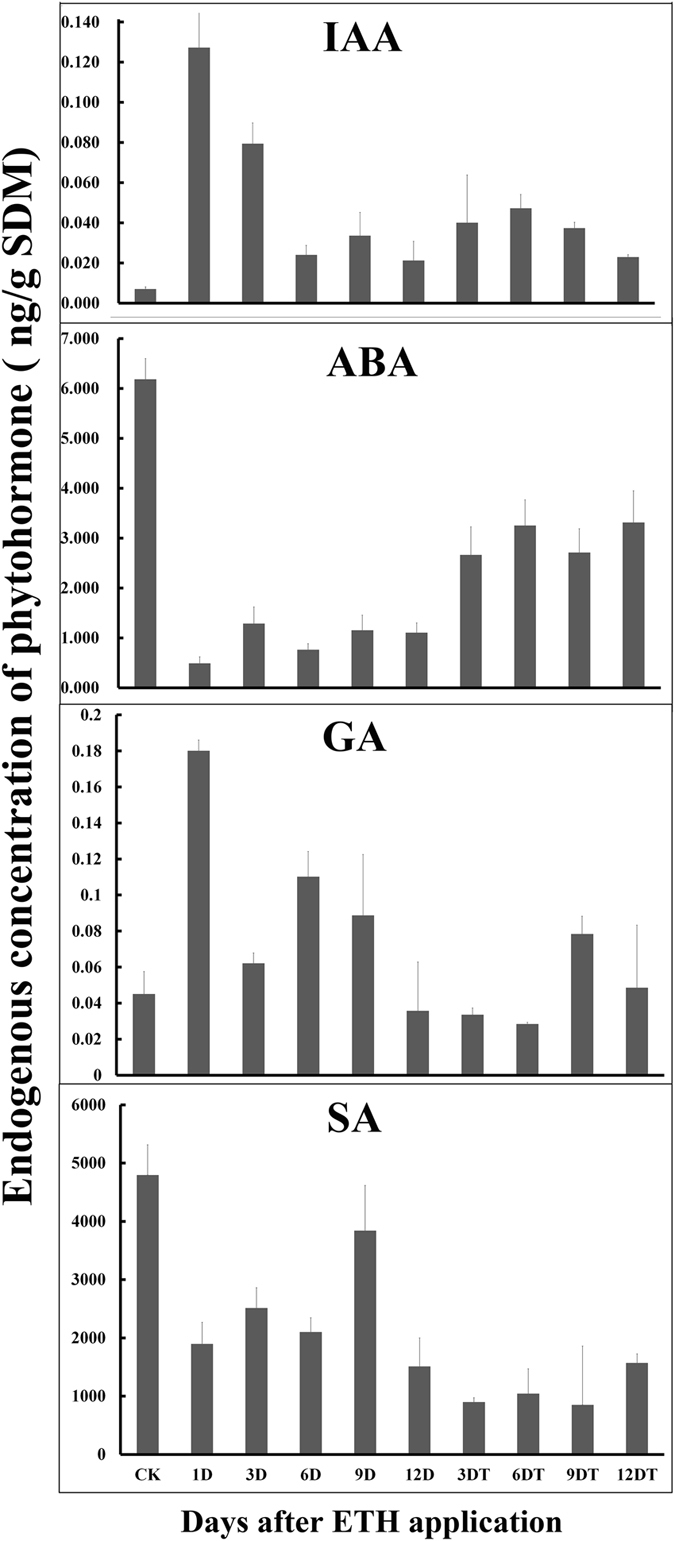
Hormone levels during ethephon treatment.Levels of IAA, ABA, GA and SA were measured in SDM shoots during time course. Values represent the mean of four independent biological replicates per time point. Bars represent standard errors.